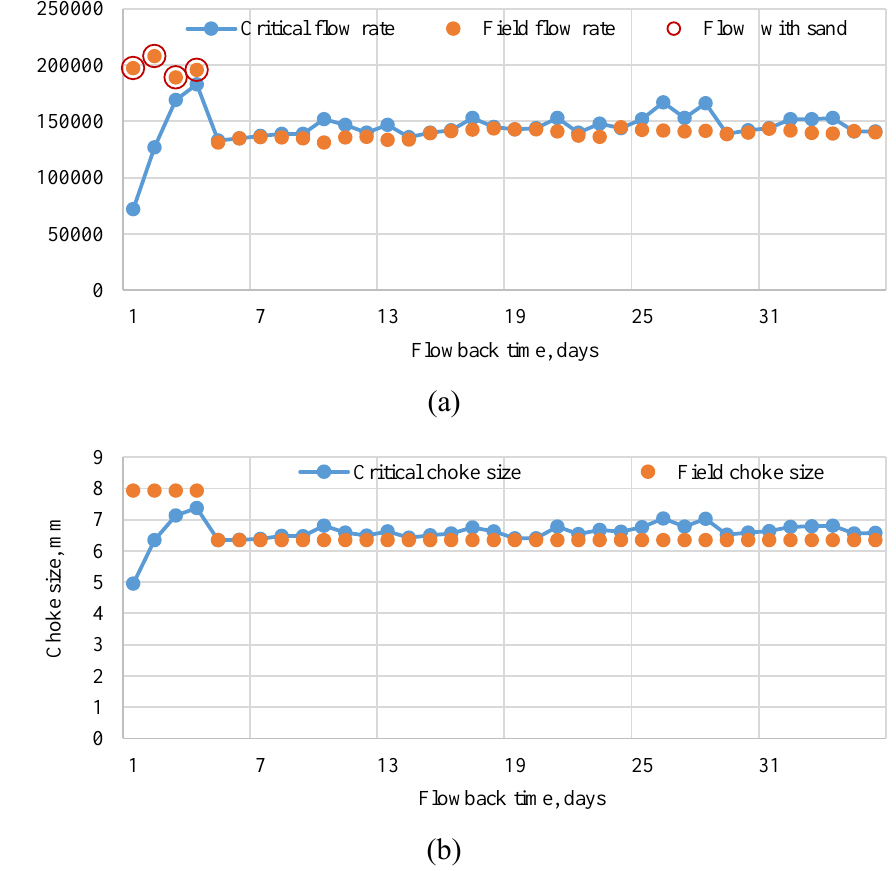
Figure 7—Flowback performance versus (a) flow rate and (b) choke